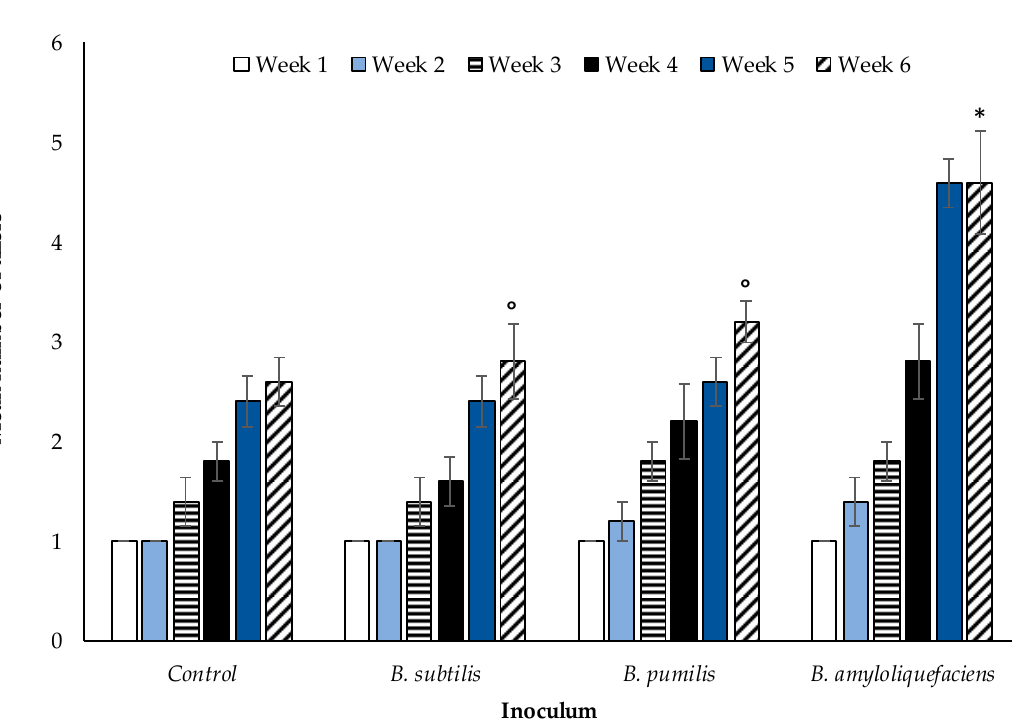
Figure 5. Average (n = 270 overall) number of tillers per plant for inoculated winter wheat over a six week period. Significant ( p < 0.005) for single factor ANOVA. TRUE Bonferroni corrections (*), FLASE Bonferroni corrections (°). Error bars = one SEM.